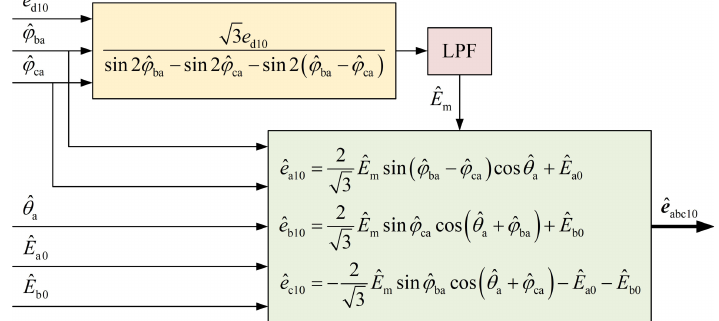
Figure 4. Reconstruction structure of the unbalanced voltages containing DC